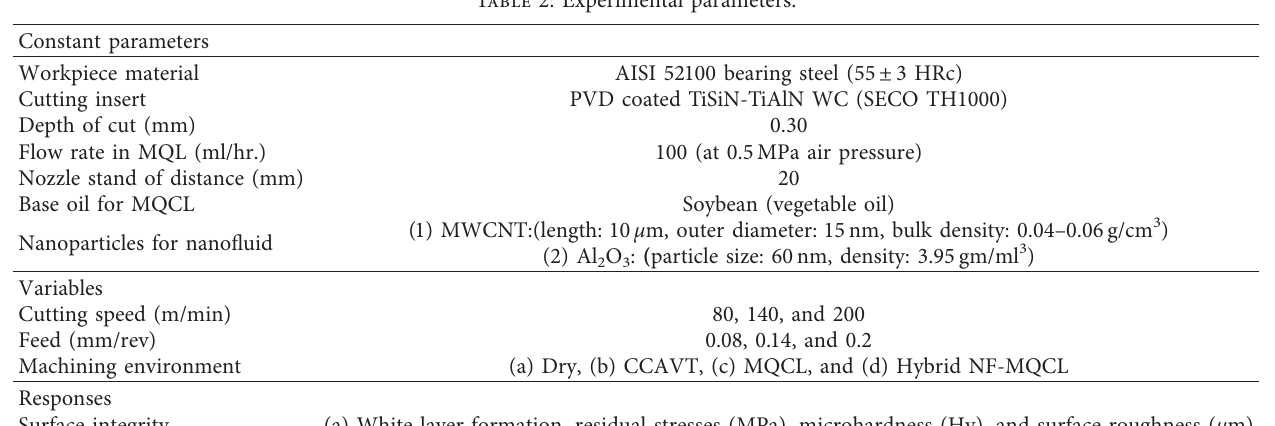
Table 2: Experimental